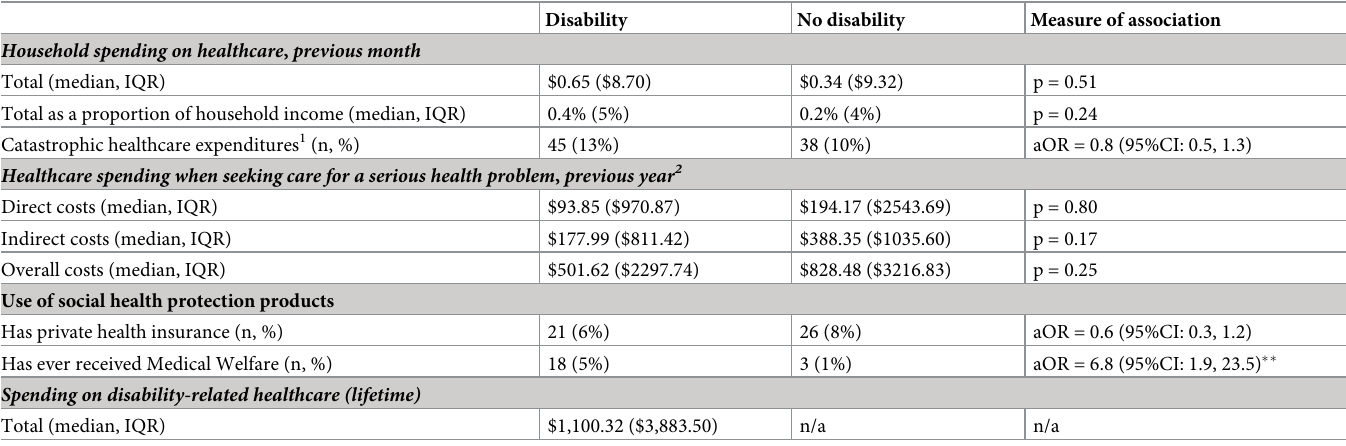
Table 5. Healthcare